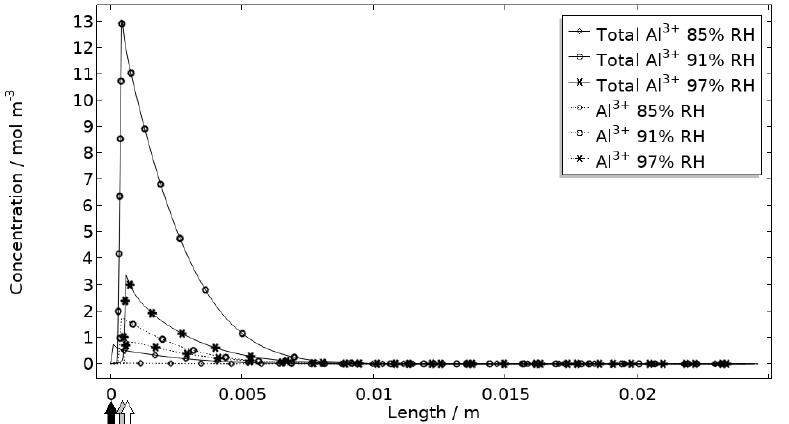
Figure 11. Modeled pH profiles at selected times along the calibration cell with 86 µg NaCl/cm 2 load at 21 °C at 85%, 91%, and 97% RH. Star and square indications mark data at the corroding surface after 2.5 h and 1 min exposure, respectively.